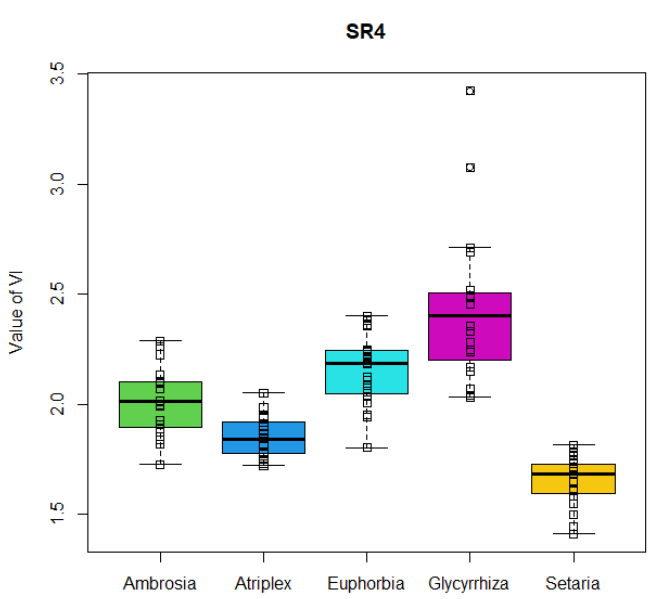
Figure 7. Boxplot of VI SR4.